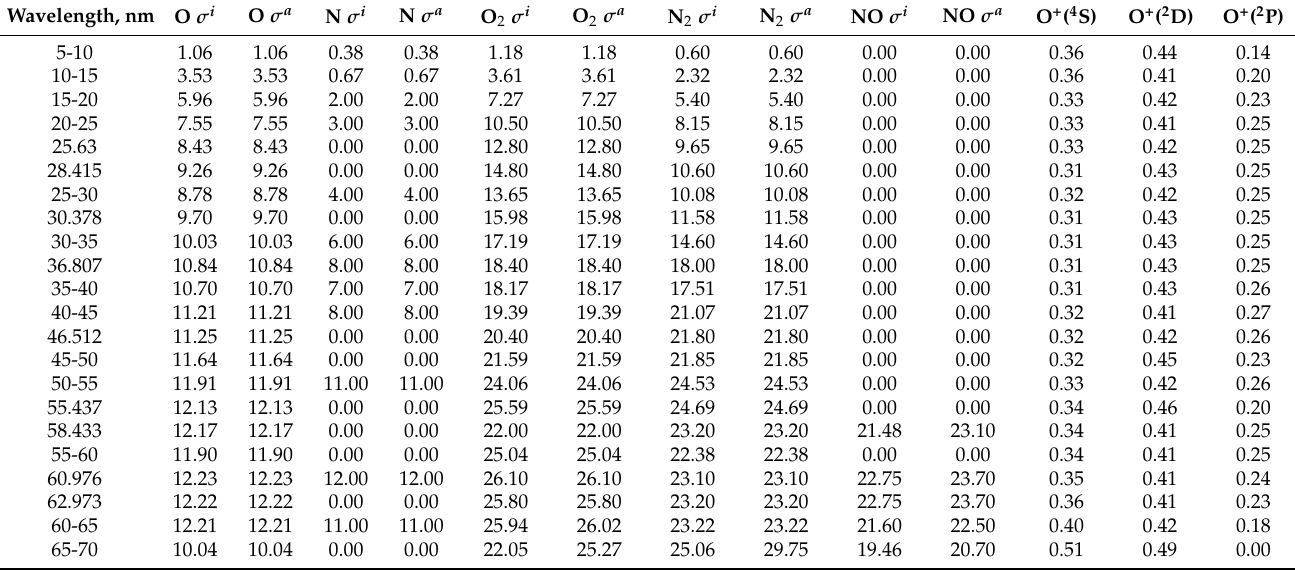
Table A2. Absorption ( σ a ) and ionization ( σ i ) cross-sections for neutrals O, N, O 2 , N 2 , and NO and probabilities of the ionization to the electronic states of atomic oxygen ions O + (4S), O + (2D), and O + (2P). Wavelength, nm O σ